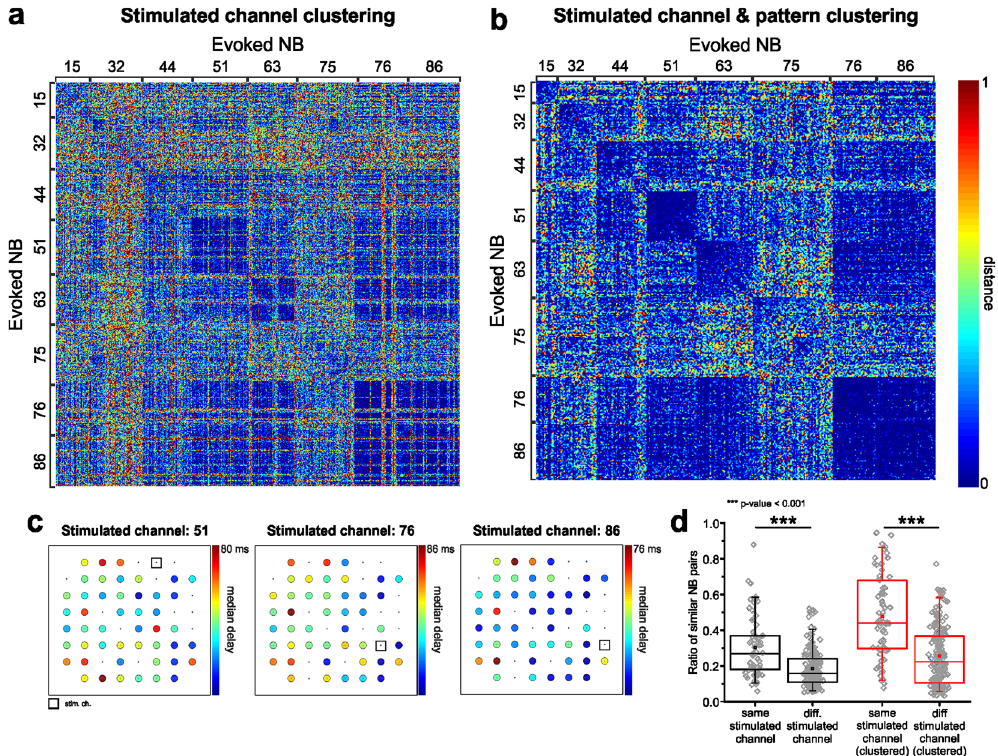
Figure 4. Evoked NBs from different sources share similar patterns. ( a ) Color-coded matrix of normalized distances among all pairs of evoked NBs (representative experiment) ordered by the corresponding stimulated channel. ( b ) Matrix of normalized distances among all pairs of evoked NBs (same experiment as in a ) ordered by the corresponding stimulated channel and selected according to the pattern clustering procedure, applied separately to each stimulated channel’s responses. Stimulated channels’ numbers are reported aside, to indicate the corresponding clusters of NB patterns (also in a ). Color-map: cool colors indicate low distances, whereas warm colors indicate high distances. Range: [0, 1]. ( c ) Color-coded maps of median propagation delays of electrode activations (with respect to the stimulus onset) for three different stimulated electrodes (same representative experiment as in a , b ). Each color-map has been rescaled according to the maximum delay, as indicated in figure. ( d ) Ratio of significantly similar patterns evoked by the same or different stimulated channels, either considering all patterns (black) or only the clustered ones (red). Box plots collect data from the full dataset. Statistically significant differences as indicated in figure has been assessed by Mann-Whitney